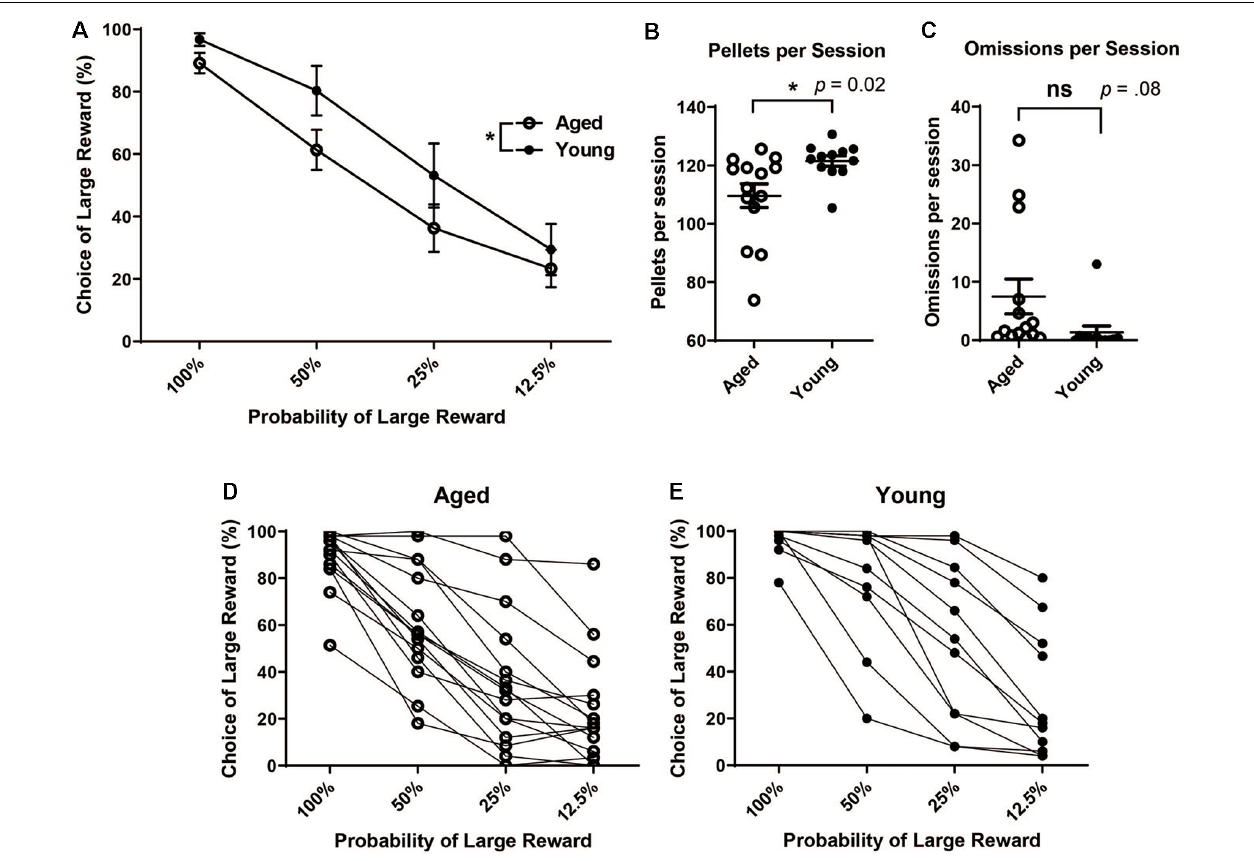
FIGURE 1 | (A) Mean ( ± SEM) choice of large rewards for all probability blocks grouped by age. Scores reflect rats’ choice of the large reward lever during the choice trials in which rats participated (i.e., not including omission trials). Aged rats chose the large risky lever significantly less often than young rats ( F (1,104) = 7.93, p < 0.01). (B) The Mean number of pellets received per session by age group. Young rats received more pellets per session on average than aged rats ( t (24) = 2.54, p = 0.02). (C) Mean number of omitted trials per session. There was not a significant difference in the number of omitted trials between groups ( t (24) =